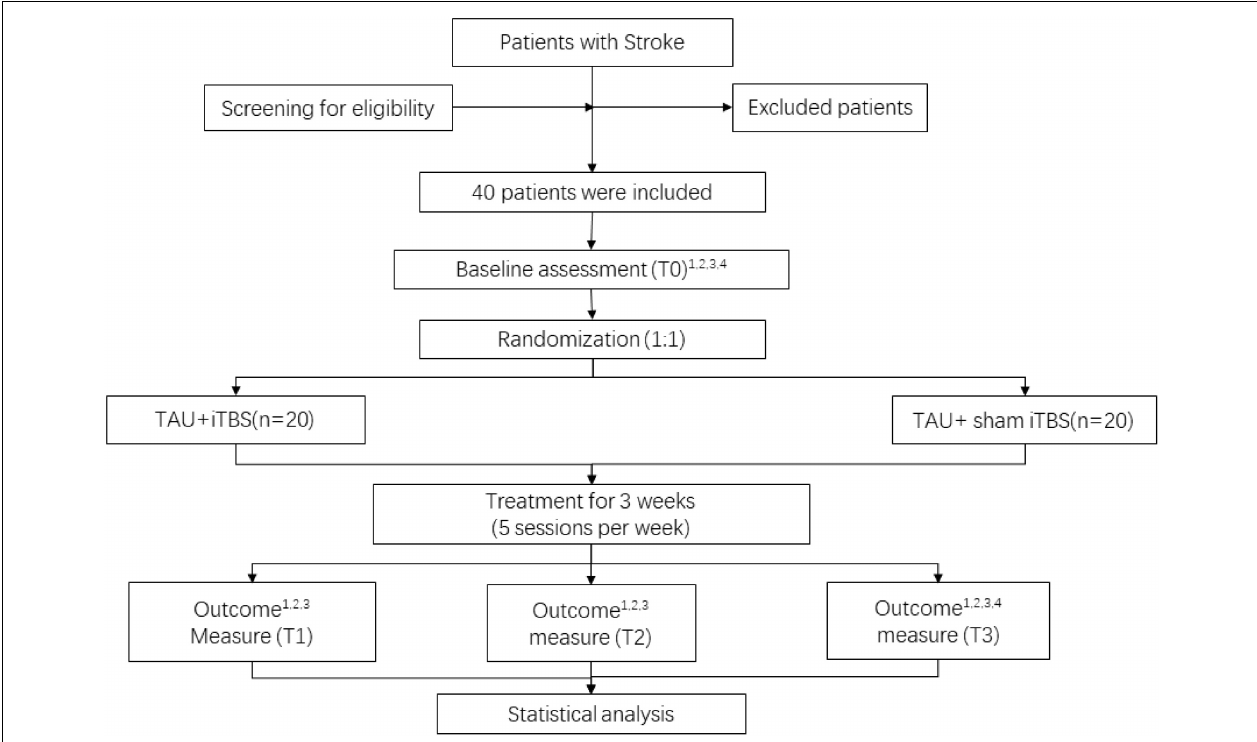
FIGURE 1 | Study flow diagram. 1 BBS, 2 FMA-LE, 3 MBI, and 4 fMRI. TAU, treatment as usual; iTBS, intermittent theta burst stimulation. T0, before intervention; T1, at the end of first week of post-intervention; T2, at the end of second week of post-intervention; T3, at the end of third week of